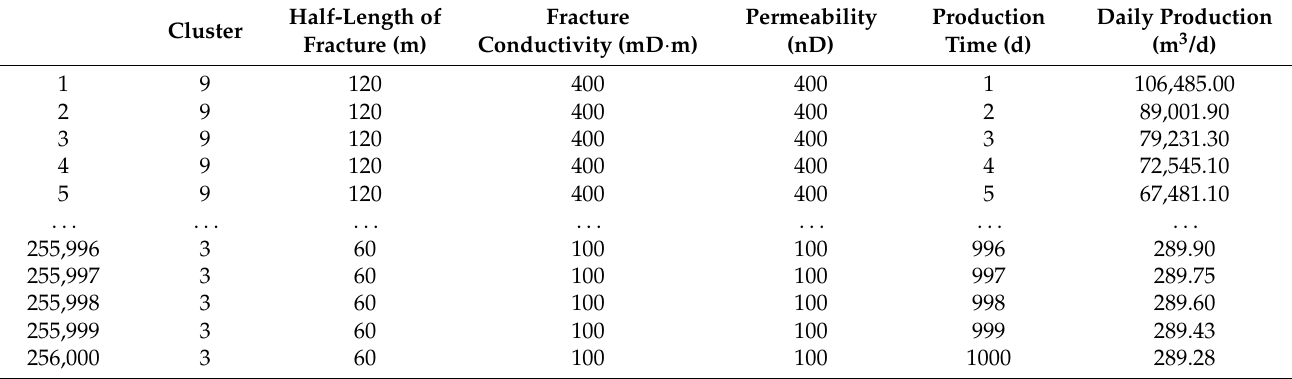
Table 2. Dataset of shale gas